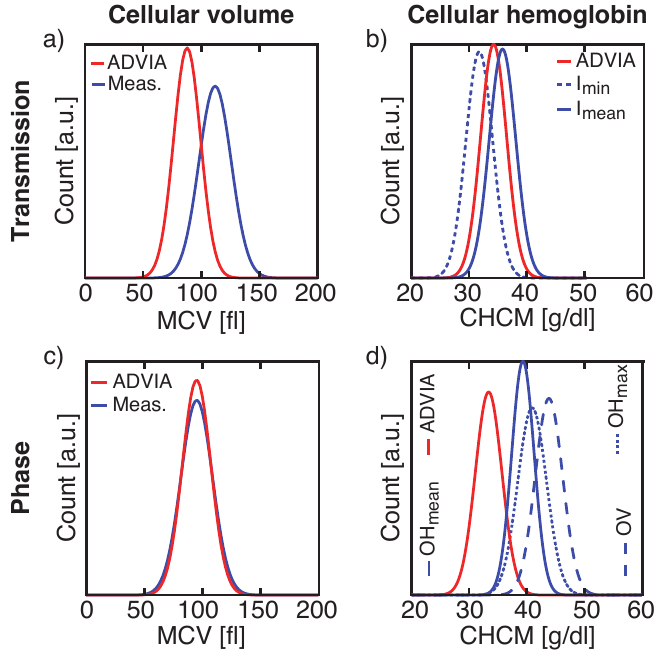
Figure 5. Comparisons of the cellular volume distribution widths and the absolute mean cellu- lar volume (MCV) values of the reference system and our measurements for transmission ( a ) and phase images ( c ) and of the cellular hemoglobin distribution widths with its absolute mean cellular hemoglobin concentration (CHCM) values of the reference system and our measurements for trans- mission ( b ) and phase images ( d ). Same donor was used for V and Hb measurements in transmission images and another donor was used for V and Hb values calculated from phase images.